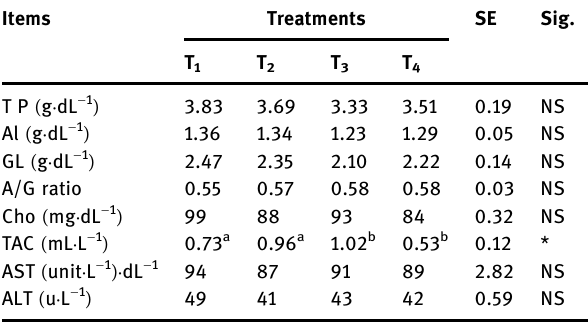
Table 3: Biochemical analysis of blood constituents as a ff ected by using biogenic ( AgNPs ) and their NP capping by acetic acid in broiler chickens Items Treatments